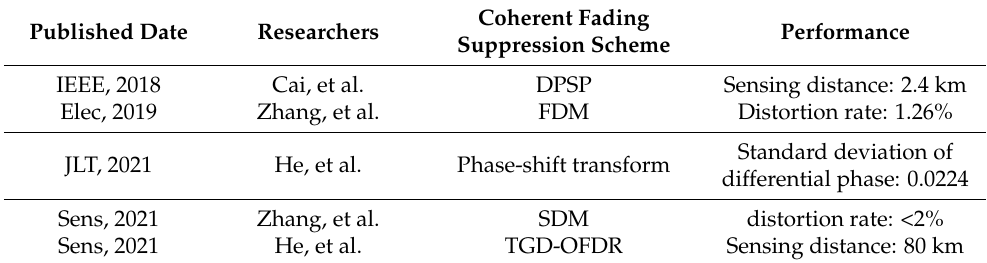
Figure 9. ( a ) Experimental setup. ( b ) Chirped pulse and sub-division into bands (offset for visibility, frequency change is linear over entire range). ( c ) Corresponding frequency bands used during signal processing [46]. Table 2. Research progress for suppression of coherent fading.